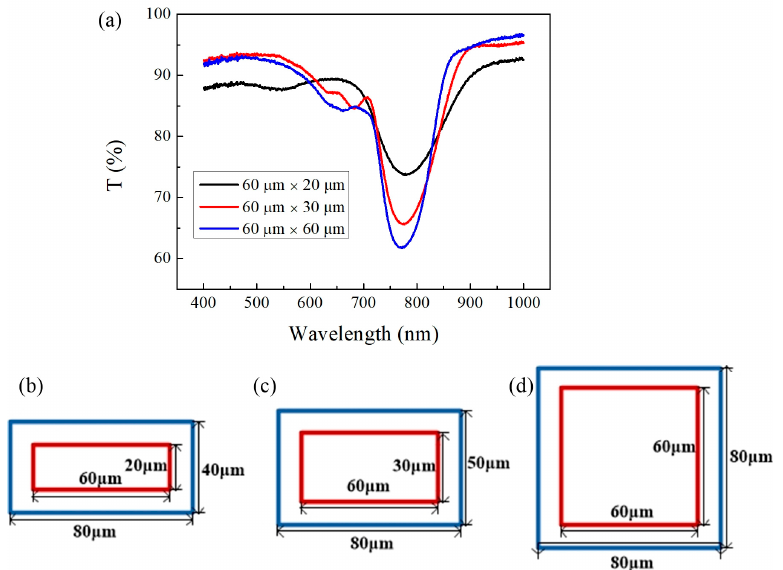
Figure 5. The transmittance and diagram of PCLC flakes in PDMS molds: ( a ) Transmittance of PCLC flakes in PDMS molds; ( b ) the diagram of the 60 µ m × 20 µ m size; ( c ) The diagram of the 60 µ m × 30 µ m size; ( d ) the diagram of the 60 µ m × 60 µ m size (The blue line means the PDMS mold and the red line means the PCLC flakes).